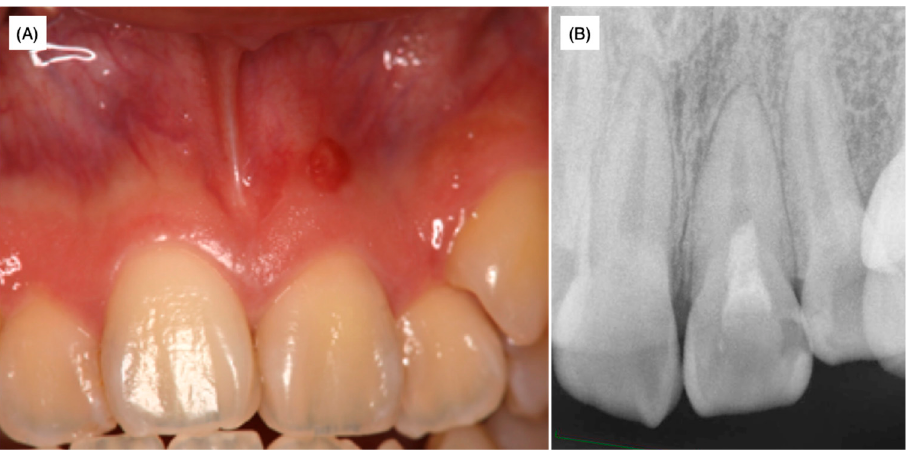
Figure 2. Preoperative intraoral photograph ( A ) and dental radiophotograph ( B ).